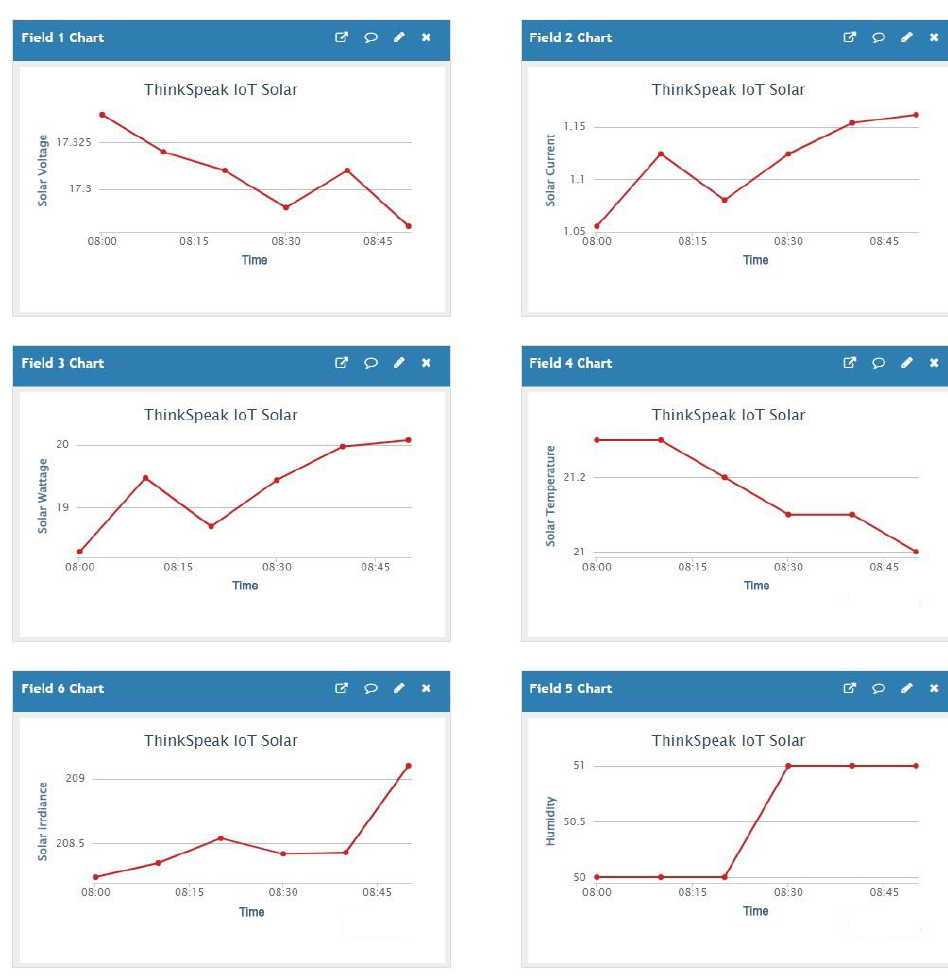
Figure 9. Real-time results for one active PV